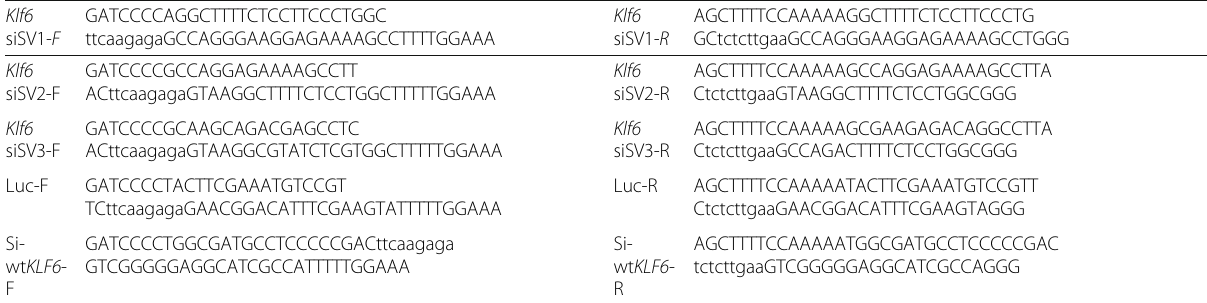
Table 1 DNA oligonucleotides for pSUPER